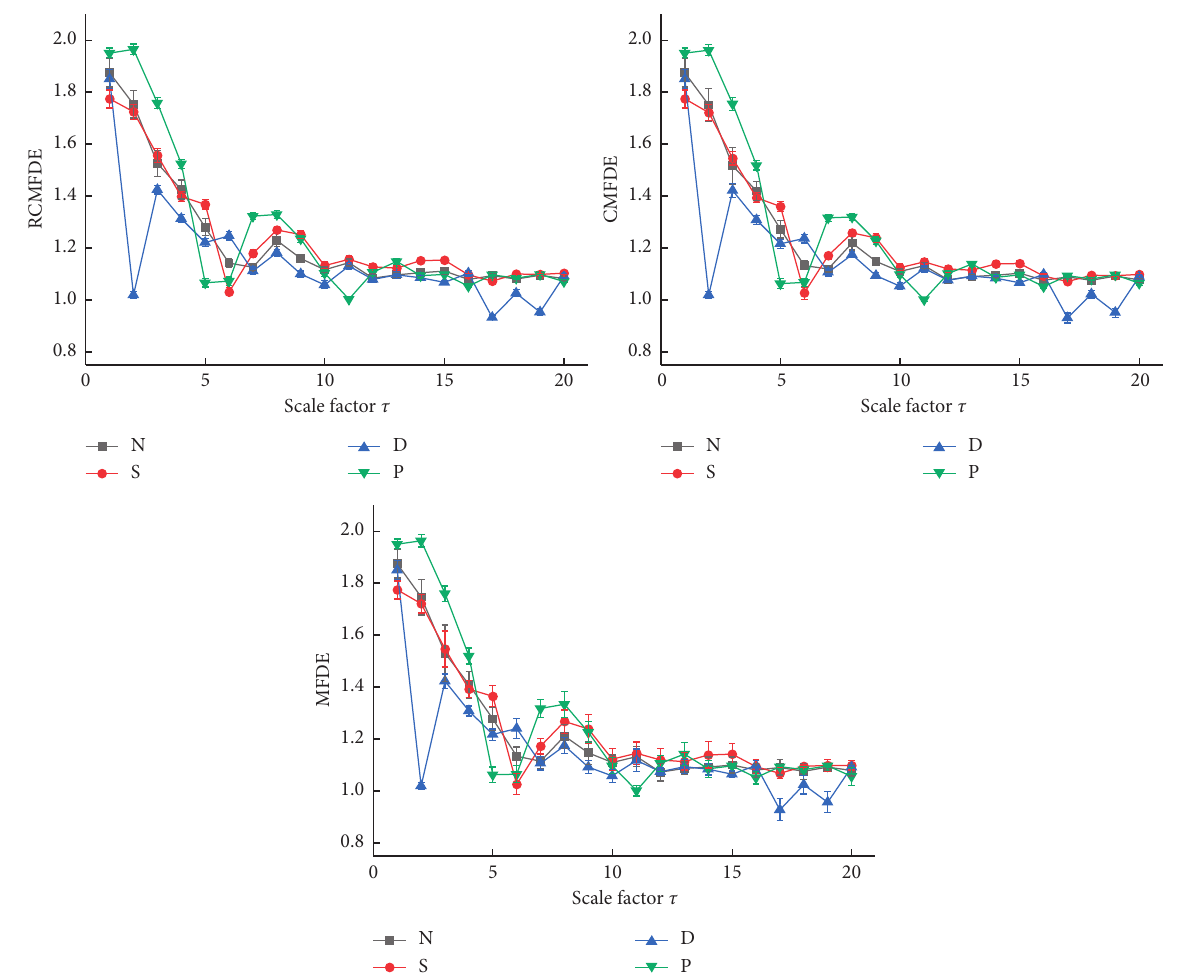
Figure 11: RCMFDE, CMFDE, and MFDE of four kinds states of the hydraulic